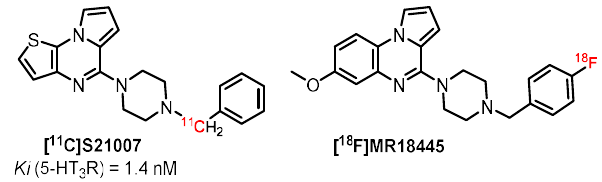
Figure 11. [ 11 C]MDL72222 and [ 11 C]KF17643